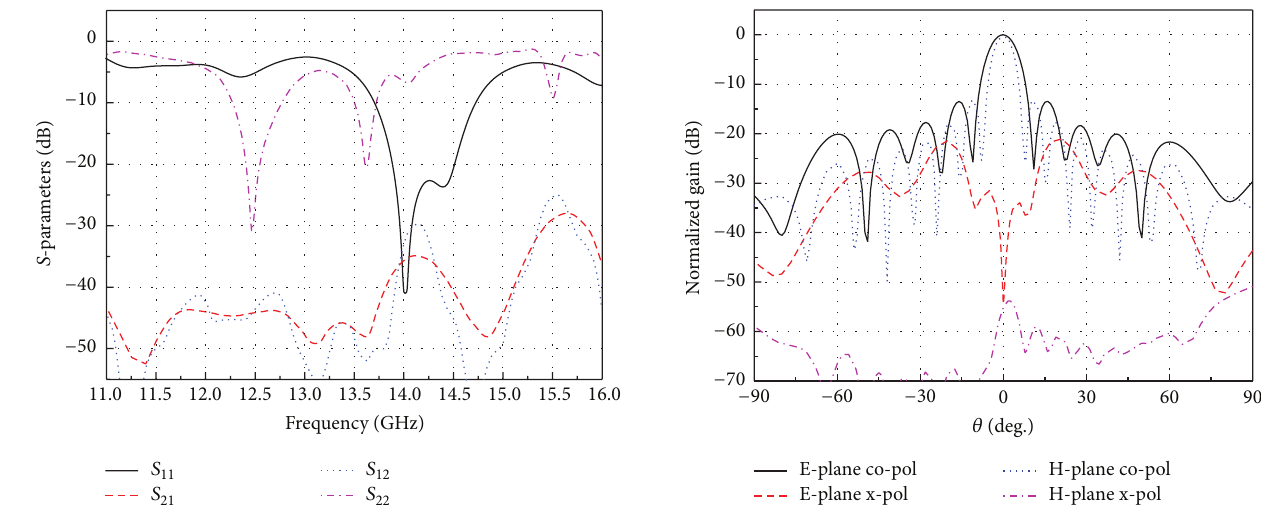
Figure 6: Simulated radiation patterns for V-port of the 8 × 10 array at 12.5 GHz.